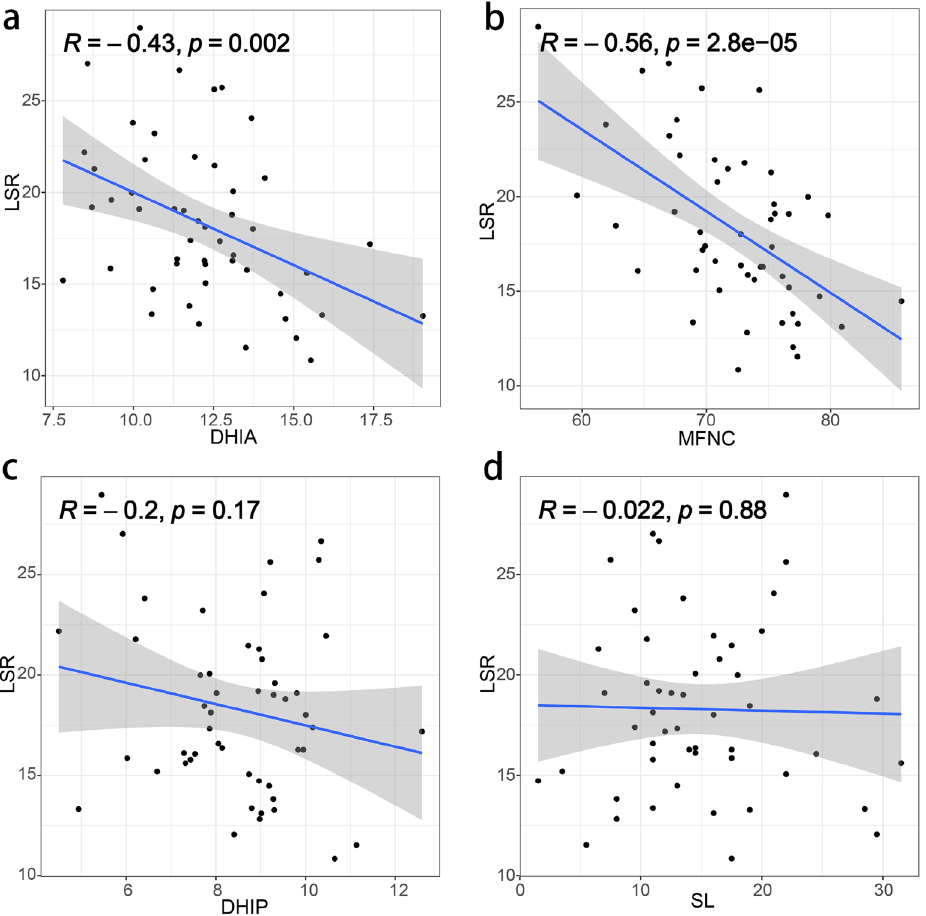
Figure 3. Correlation analysis showed that LSR was negatively correlated with the DHIA ( a ) and the MFNC ( b ), while there were no correlations between LSR and DHIP ( c ) and SL ( d